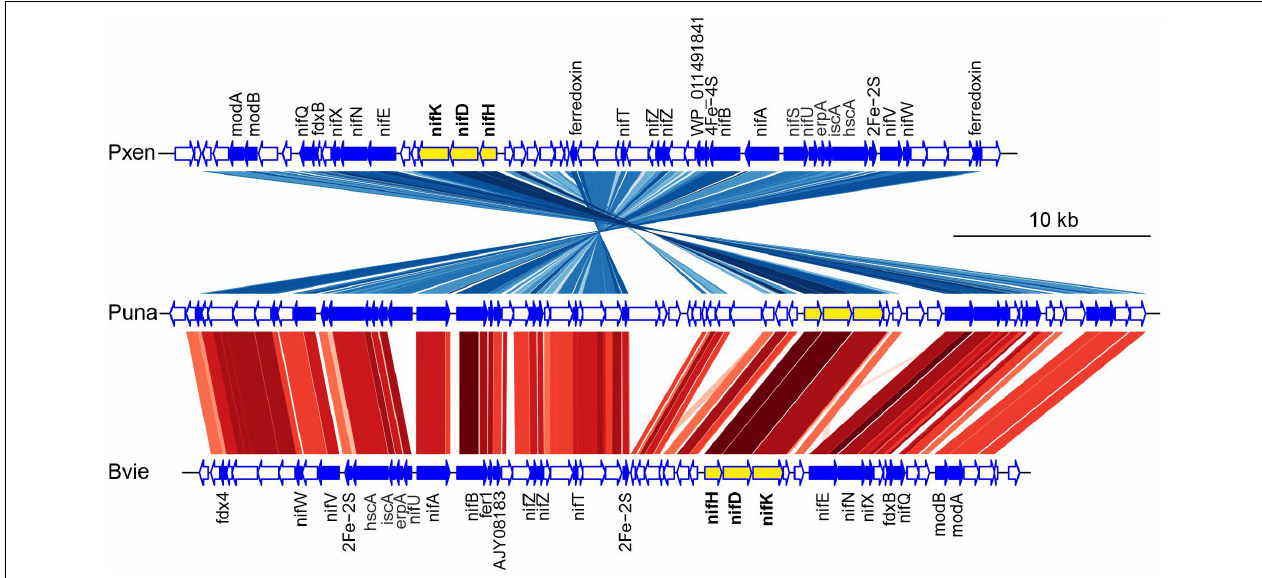
FIGURE 4 | Gene synteny of nitrogen fixation gene clusters in Paraburkholderia xenovorans (Pxen), P. unamea (Puna), and Burkholderia vietnamiensis (Bvie). The genome region with nitrogen fixation gene cluster was analyzed as dnaseg in genoplotr package in R. Protein sequence comparisons by tBLASTx with the criteria, e -value < e-100 and bit score ≥ 100 were applied as comparison in genoplotr. Key to colored lines in gene comparisons: Darker shaded lines indicates strength of similarity, red indicates genes in the same orientation and blue reverse orientation. Key to gene colors: yellow, key nitrogen fixation cluster gene; blue, genes directly related to nitrogenase maturation and function; white, other putative genes. fdx4 , ferredoxin gene; nifW , nitrogenase-stabilizing/protective protein gene; nifV , homocitrate synthase gene; hscA , Fe-S protein assembly chaperone gene; iscA , Fe-S cluster assembly protein gene; erpA , Fe-S cluster insertion protein gene; nifU , Fe-S cluster assembly scaffold gene; nifS , cysteine desulfurase gene; nifA , nif-specific regulatory protein gene; nifB , nitrogenase cofactor biosynthesis protein gene; fer1 , ferredoxin-1 gene; WP_011491841 , Fe-S cluster assembly accessory family protein gene; AJY08183 , Fe-S cluster assembly accessory family protein